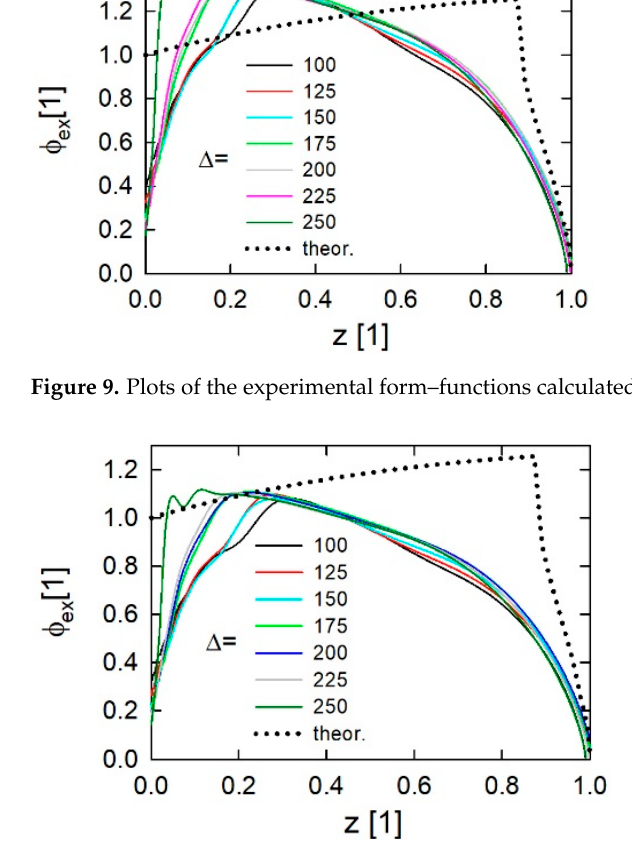
Figure 10. Plots of the experimental form–functions calculated using the mean θ 2 value.